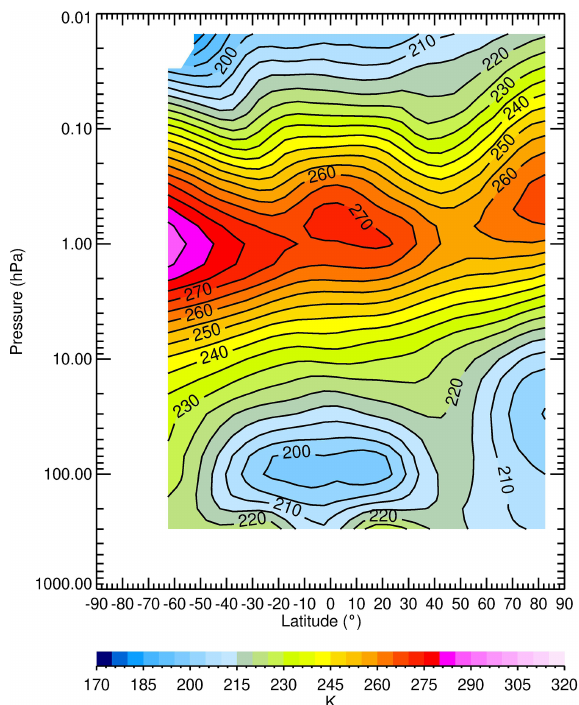
Figure 2. Zonal-average, descending-mode temperature for January 1979. CI is 5K.